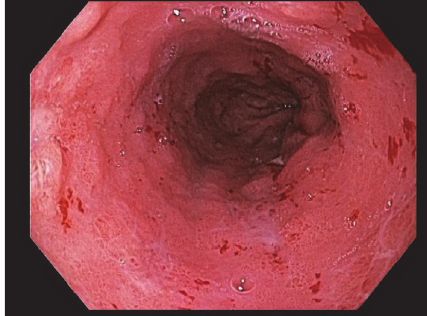
Figure 5: Patient 2 (white light endoscopy). Esophagus after multi- ple hot snare polypectomies and RFA.